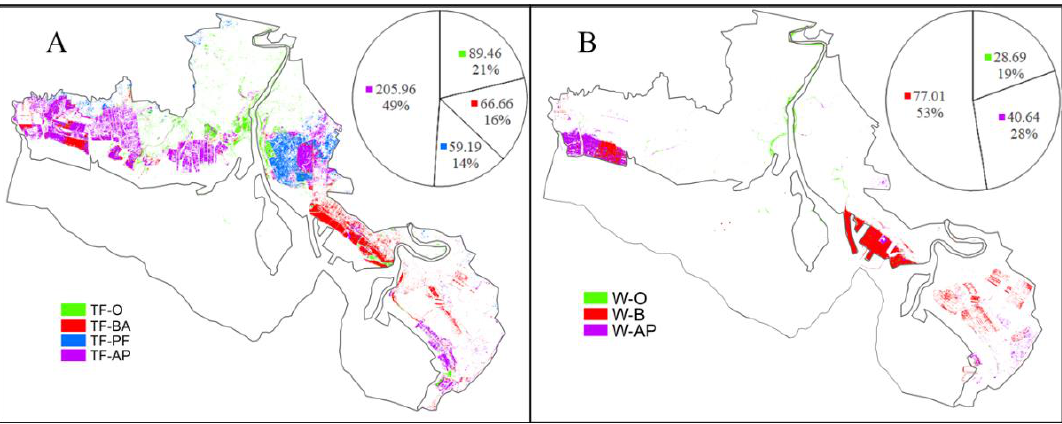
Figure 8. The spatial distribution, quantity (km 2 ), and percentage of areal changes in tidal flats and shallow marine water. Tidal flats transformed to other land cover ( A ) and shallow marine water transformed to other covers ( B ). BA: built-up area; PA: reed field; PF: paddy field; TF: tidal flats; SMW: shallow marine water; AP: aquaculture ponds; O: other covers.